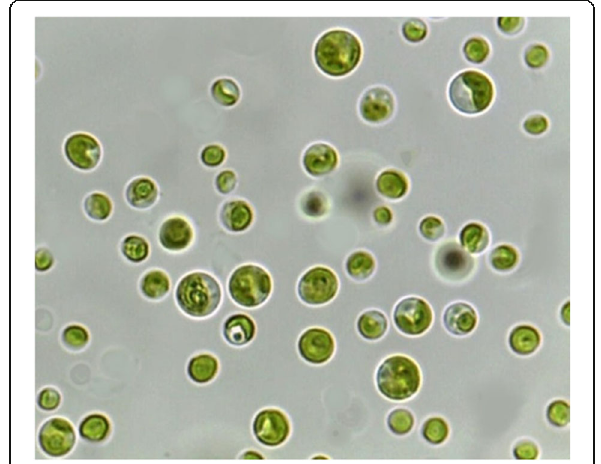
Fig. 1 Photomicrograph of the young and mature vegetative Chlorella sp. MF1 cells under optic microscope (× 40)